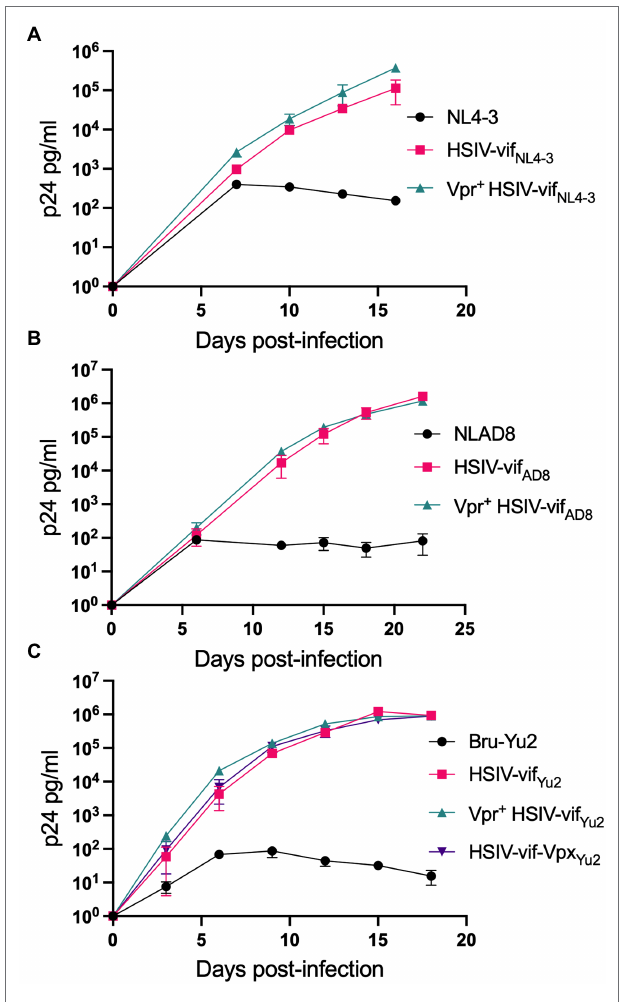
FIGURE 4 | Vpr and Vpx expressing HSIV replicate in PTM CD4 T cells. Cells were infected in duplicate with HSIV-vif NL4-3 (A) , HSIV-vif AD8 (B) , and HSIV-vif Yu2 (C) variants at an MOI of 0.01. Virus supernatants were collected every 3–4 dpi and assayed for p24 levels.